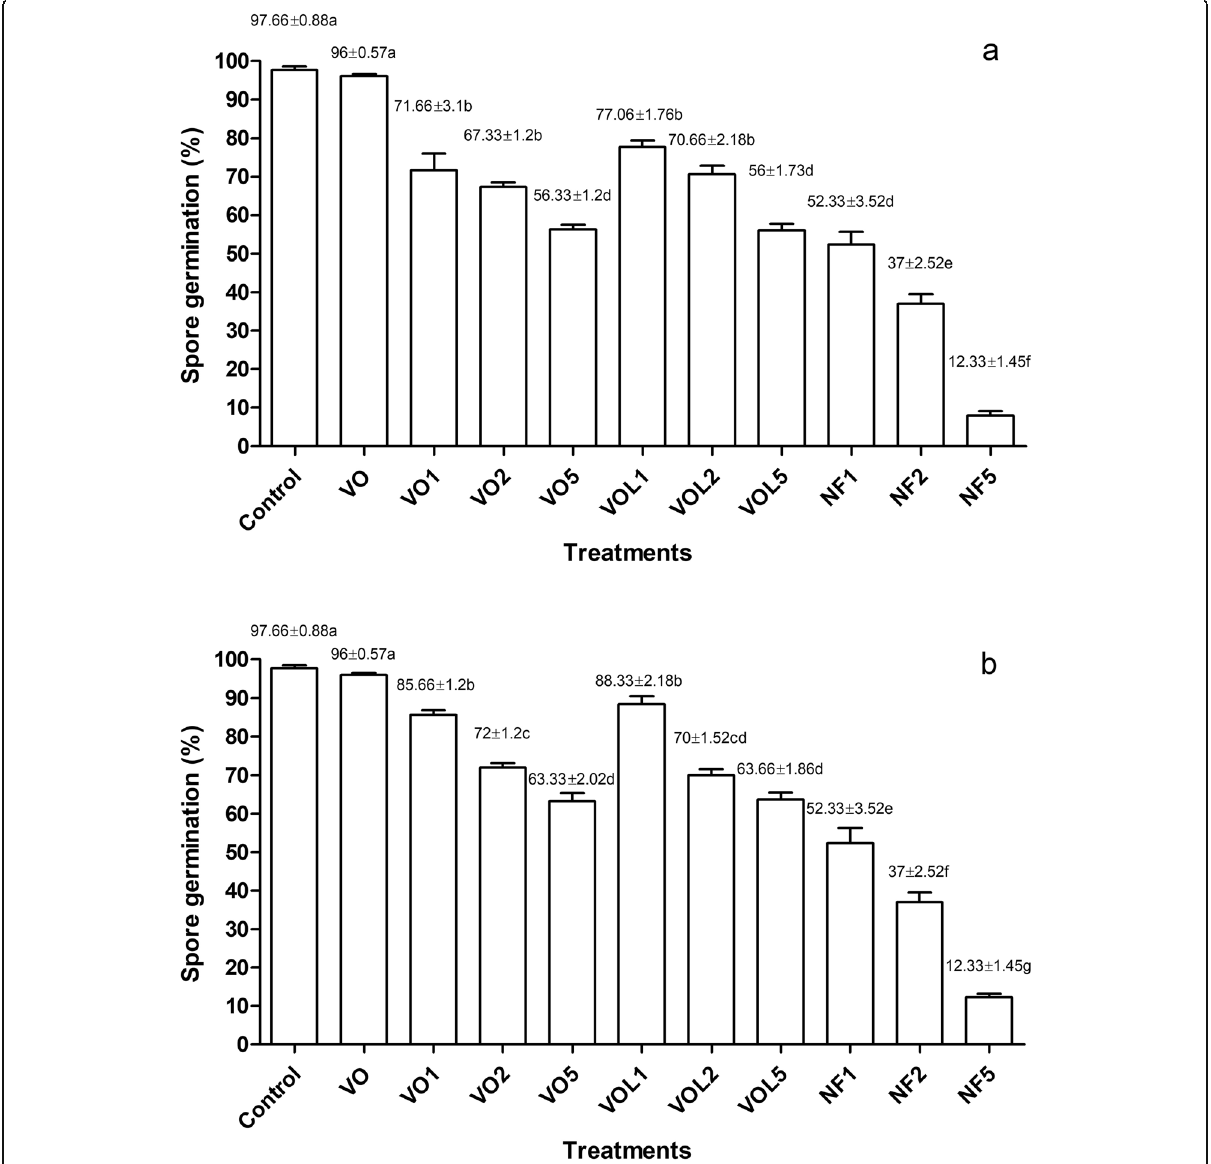
Fig. 2 Viability of Trichoderma asperellum spores in oil formulations with vegetable oil (VO) and exposed to UVR. a Spores in VO + UV-C. b Spores in VO + UV-B. VO, VO without UVR; VOL, VO + lignosulfonate without UVR; NF, no formulation. Numbers in each treatment indicate exposure time to UVR (minutes). Letters indicate statistical differences ( P <